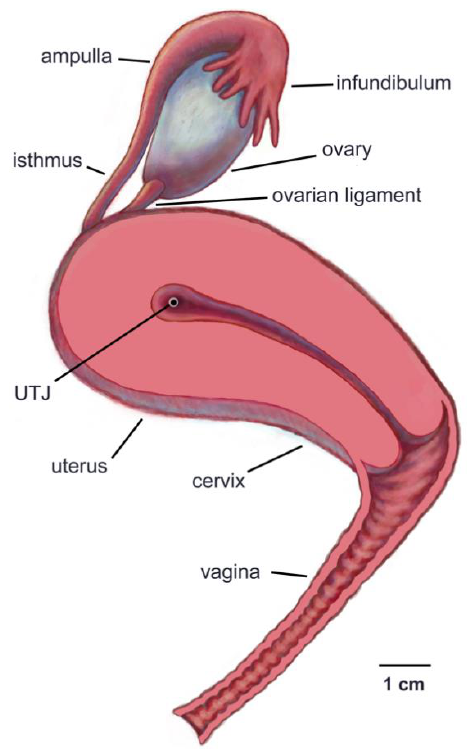
Figure 2. Left lateral view of the human female reproductive tract. The uterus, cervix and vagina have been bisected to show the entrance to the cervix and the uterotubal junction (UTJ). Only the right ovary and oviduct are shown. The ovarian ligament attaches the ovary to the uterus.